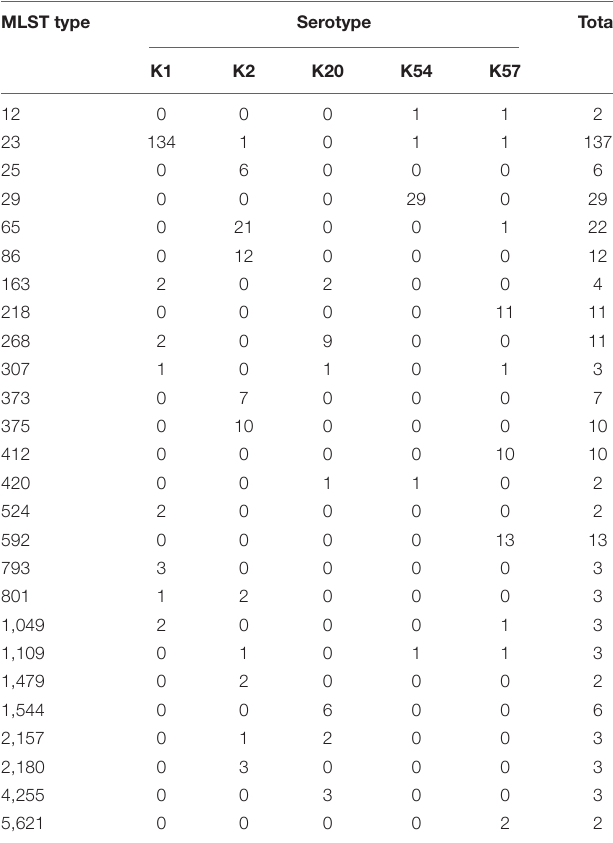
TABLE 2 | Multi-locus sequence typing (MLST) of K1, K2, K20, K54, and K57 serotypes of bacteremic Klebsiella pneumoniae isolates (only MLST types present in more than one isolate are